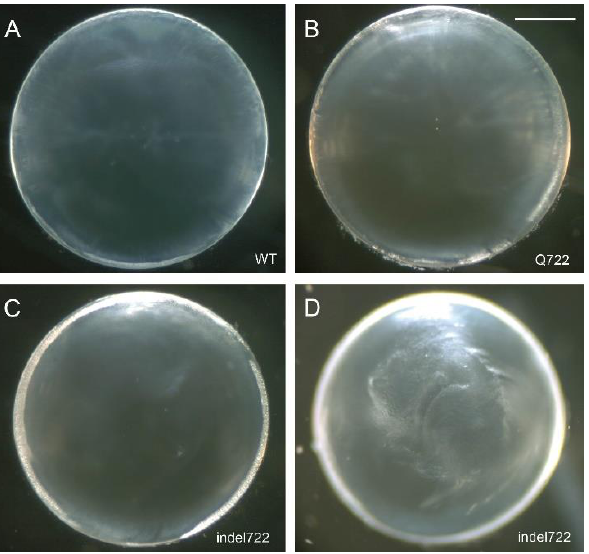
Figure 2. Epha2 -mutant lens phenotype. ( A – D ) Representative dissecting-microscope images of wild-type ( A ), Epha2 -Q722 ( B ) and Epha2- indel722 ( C , D ) lenses (P21) taken with the anterior pole down under dark-field illumination focused either on the lens periphery or equator region ( A – C ) or the posterior polar surface ( D ). Scale bar: 500 µm.